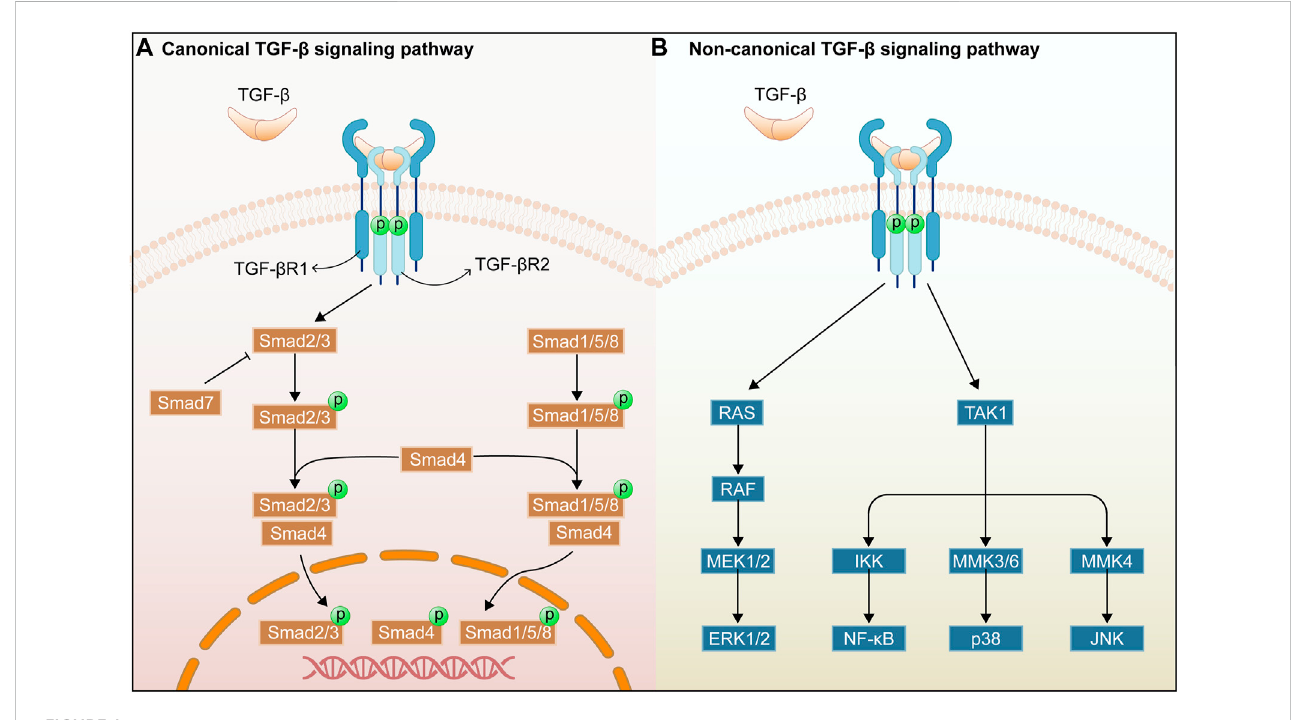
FIGURE 1 Overview of TGF- β /Smad signaling pathway. Canonical TGF- β signaling pathway (A) . Non-canonical TGF- β signaling pathway (B) .